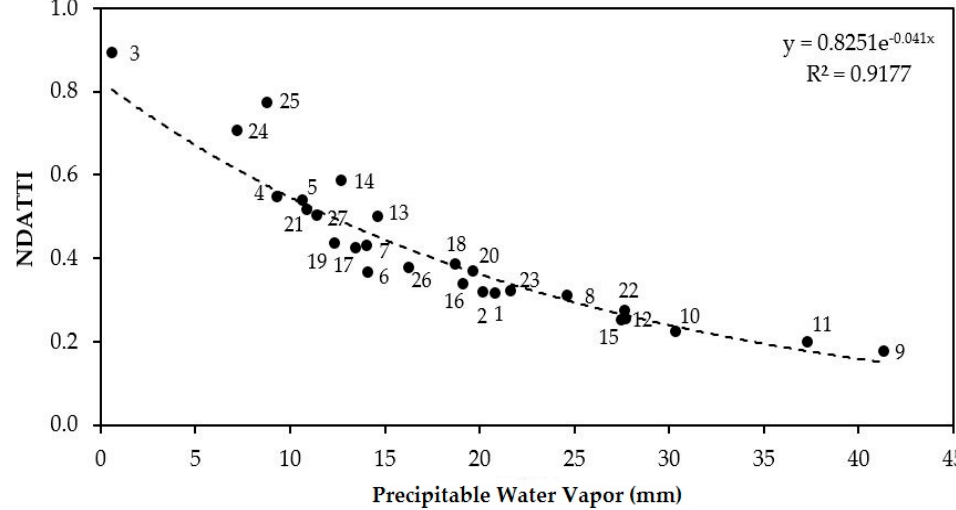
Figure 6. Normalized Difference Accumulated Thermal Time Index (NDATTI) as a function of precipitable water vapor across ecoregions of the Western Hemisphere.